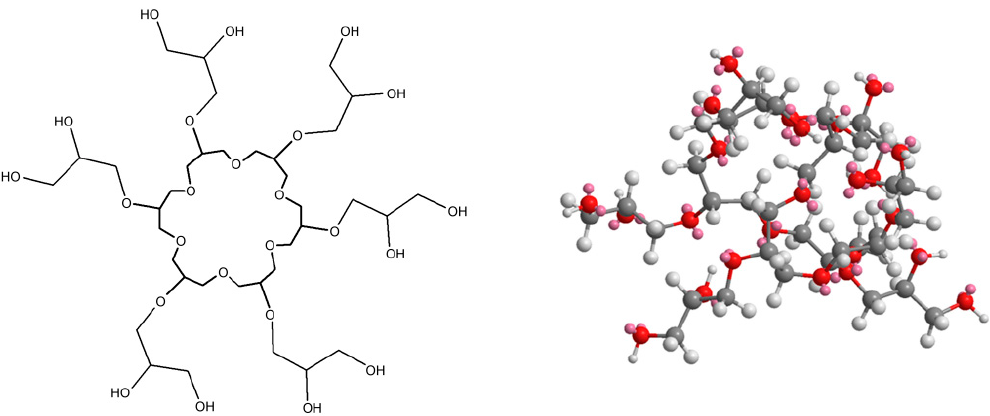
Figure 7. Structures of studied polymer—S XVI Mn = 3250, D = 1.21.